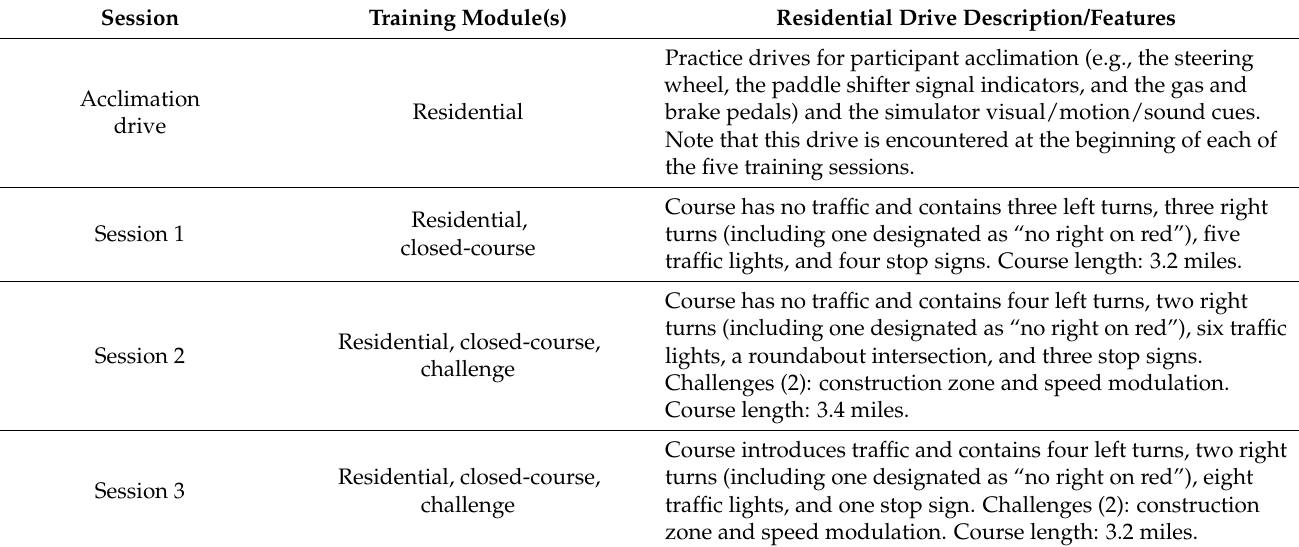
Table 1. Overview of Training Modules for each Instructional